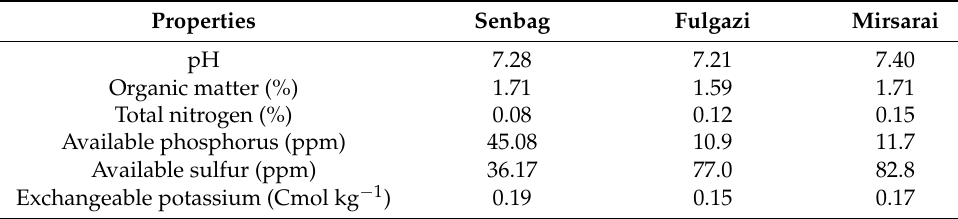
Table 1. Nutrient analysis of soil at 0–15 cm